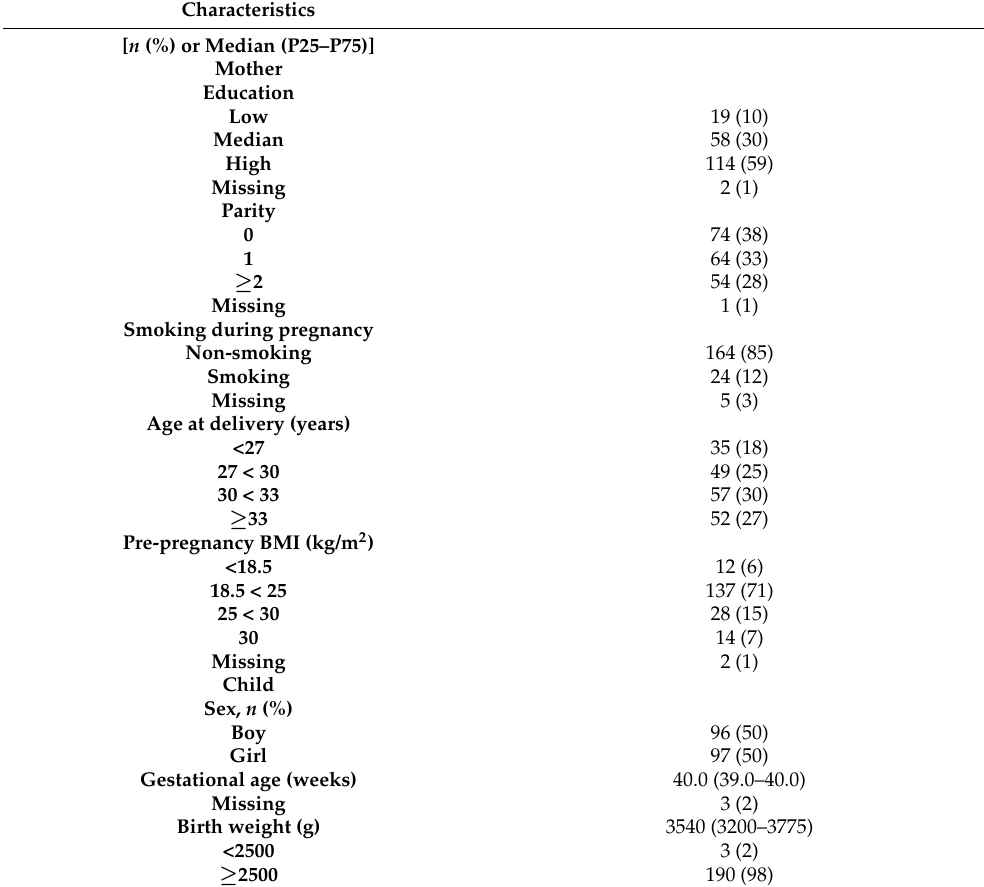
Table 1. Study population characteristics of 193 mother–child pairs, Flanders, Belgium. Characteristics